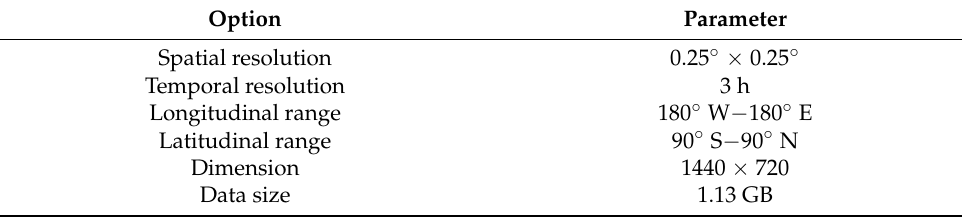
Table 1. Summary of the current data.